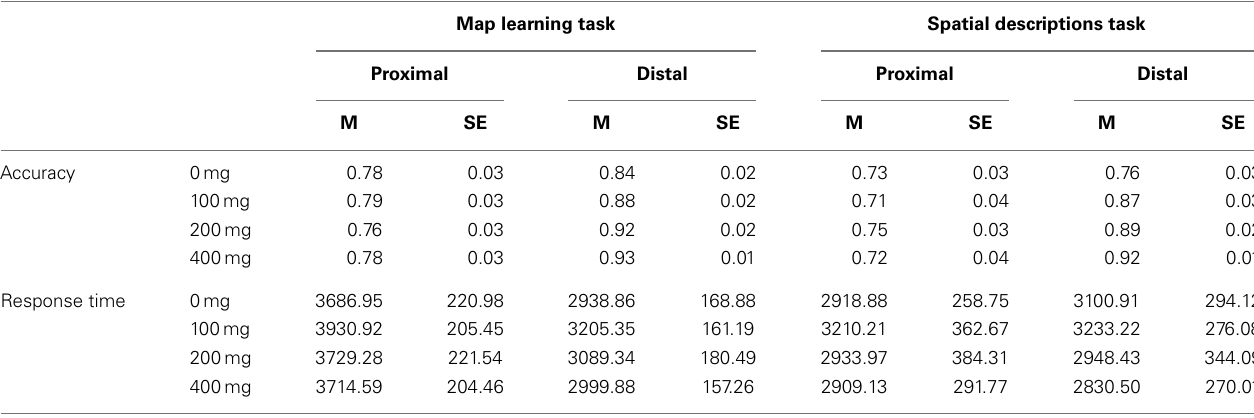
Table 3 | Experiment 1 map learning task and spatial description task mean accuracy and response time in low habitual caffeine consumers ( n =